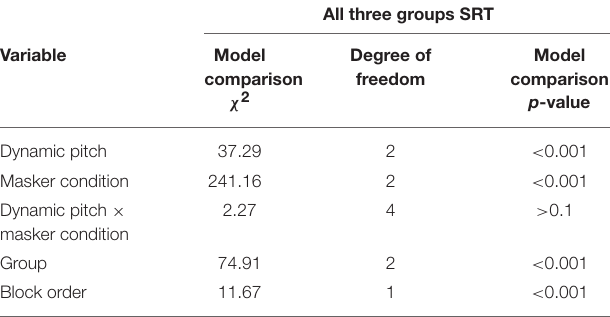
TABLE 1 | Model comparison χ 2 and p -values for speech recognition in maskers ( n = 60).